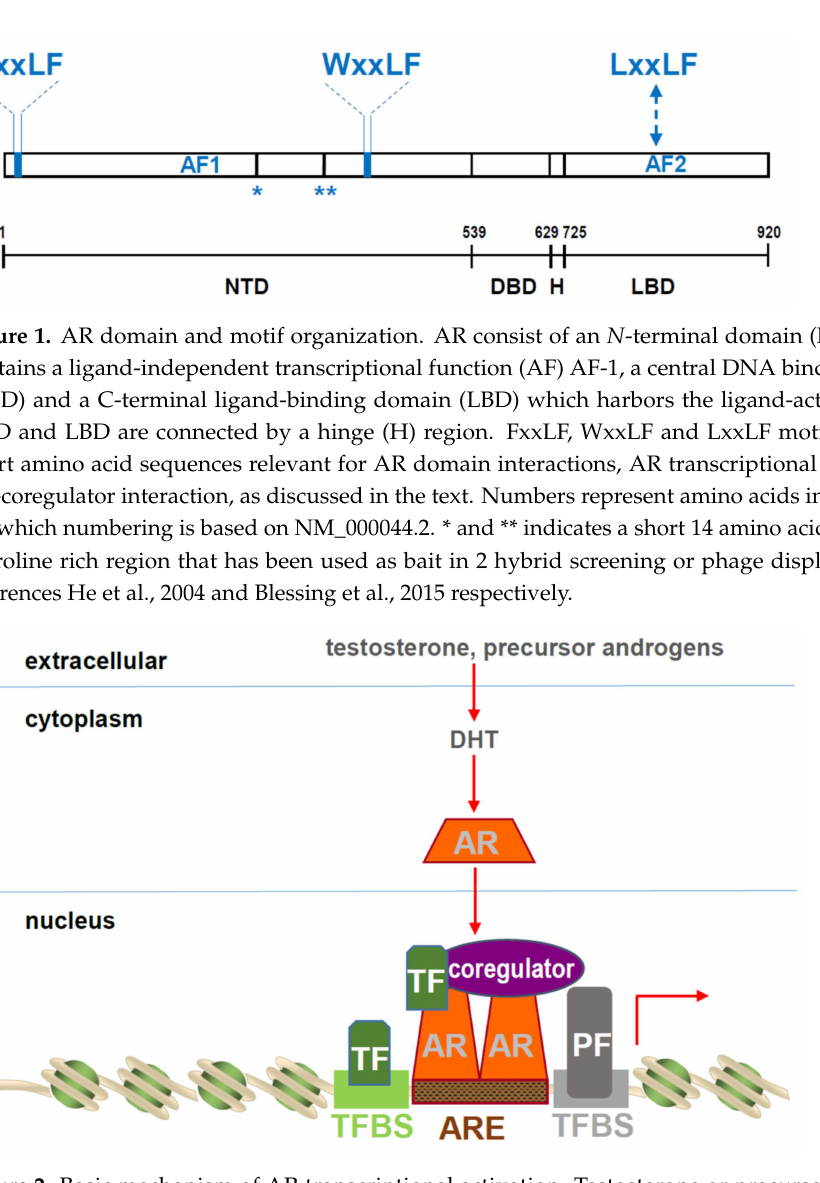
Figure 2. Basic mechanism of AR transcriptional activation. Testosterone or precursor androgens enter CaP cells and are converted into the most bioactive androgen dihydrotestosterone (DHT). DHT binding activates AR, which results in cytoplasmic to nuclear AR re-localization and AR dimerization. AR binds as a dimer to Androgen Response Elements (AREs) in AR target genes, where it associates with 3 classes of transcriptional regulators to mediate AR target gene transcription. These regulators consist of pioneer transcription factors (PFs), coregulators, and secondary transcription factors (TFs). TFBS, transcription factor binding